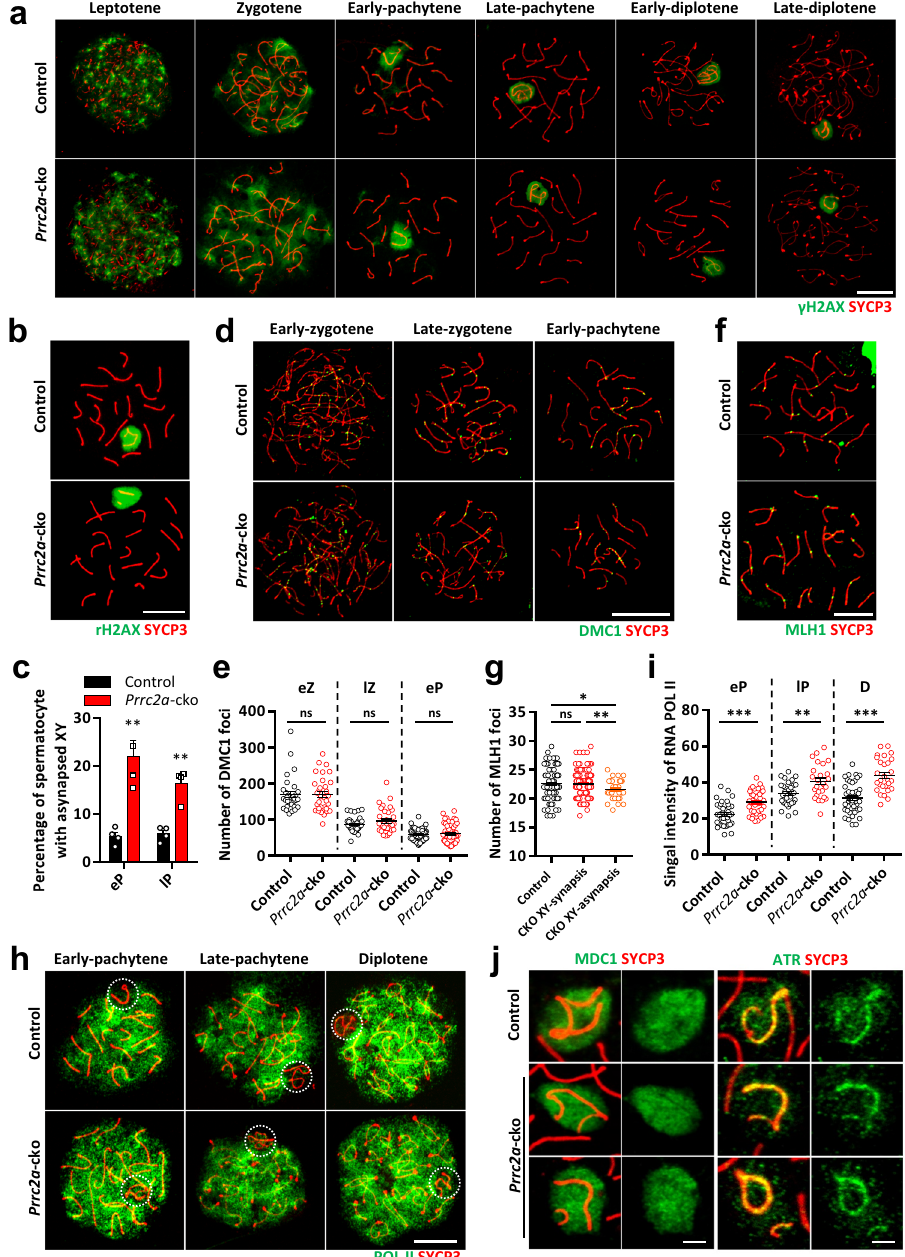
Fig. 2 | PRRC2A de fi ciency leads to XY asynapsis and impaired MSCI. a , b Immunostaining of γ H2AXand SYCP3on chromosome spreads of control and PRRC2A-null spermatocytes. b Represent PRRC2A-null spermatocytes with XY asynapsis. Scale bar, 10 μ m. c Percentage of early or late spermatocytes with XY asynapsisintotalspermatocytesfromP60controland Prrc2a -ckotestes.Morethan 500 chromosome spreads of spermatocytes from 4 mice were counted in each group of control and Prrc2a -cko. Two-sided student ’ s t -test. Error bars, mean± SEM. p =0.0028(foreP),0.0011(forlP).Sourcedataareprovided asaSourceData fi le. d , e Immunostaining of DMC1 and SYCP3 on chromosome spreads and quan- ti fi cation of DMC1 foci distributed on chromosomes in control and Prrc2a -cko early-zygotene (Control, n =31; Prrc2a -cko, n =32), late-zygotene (Control, n =38; Prrc2a -cko, n =34), and early pachytene (Control, n =57; Prrc2a -cko, n =48) sper- matocytes. Two-sided student ’ s t -test. Error bars, mean±SEM. p =0.9496 (for eZ), 0.1636 (for lZ), 0.4683 (for eP). Scale bar, 10 μ m. Source data are provided as a Source Data fi le. f , g Immunostaining of MLH1 and SYCP3onchromosomespreads